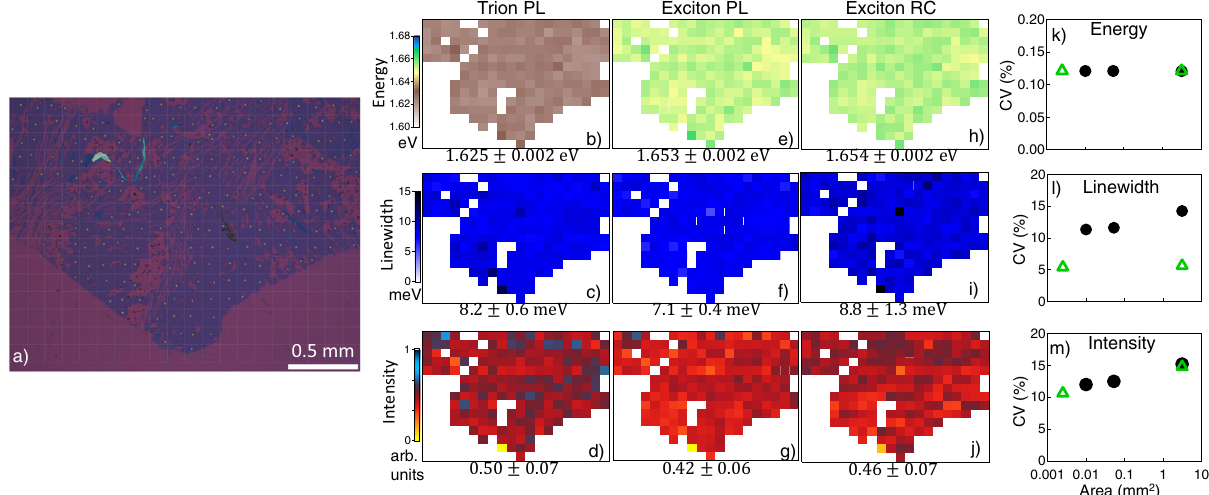
Fig.2|Uniformityoftheopticalpropertiesovermm-scale.a Opticalmicroscope imageofaD/MoSe 2 /DMML,wherethe fi eldofviewof2.500×1.875mm 2 isdivided intoa20×15gridof125×125 μ m 2 squarepixelsasmarkedbythegreylines,andPL and RC are measured at a spot (marked by the yellow dots) in each pixel, where there are no visible microscopic wrinkles or cracks. b – j Maps of the peak energy